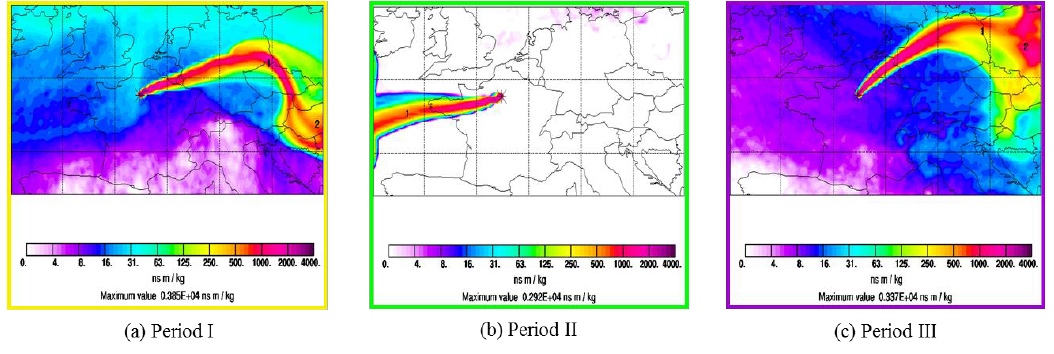
Fig. 6. Backward trajectories characterizing the air masses of the three contrasted OH reactivity periods (a) continental air masses on 27 January, (b) ocean air masses on the 3rd of February and (c) continental air masses on 9 February Source: FLEXPART model (see